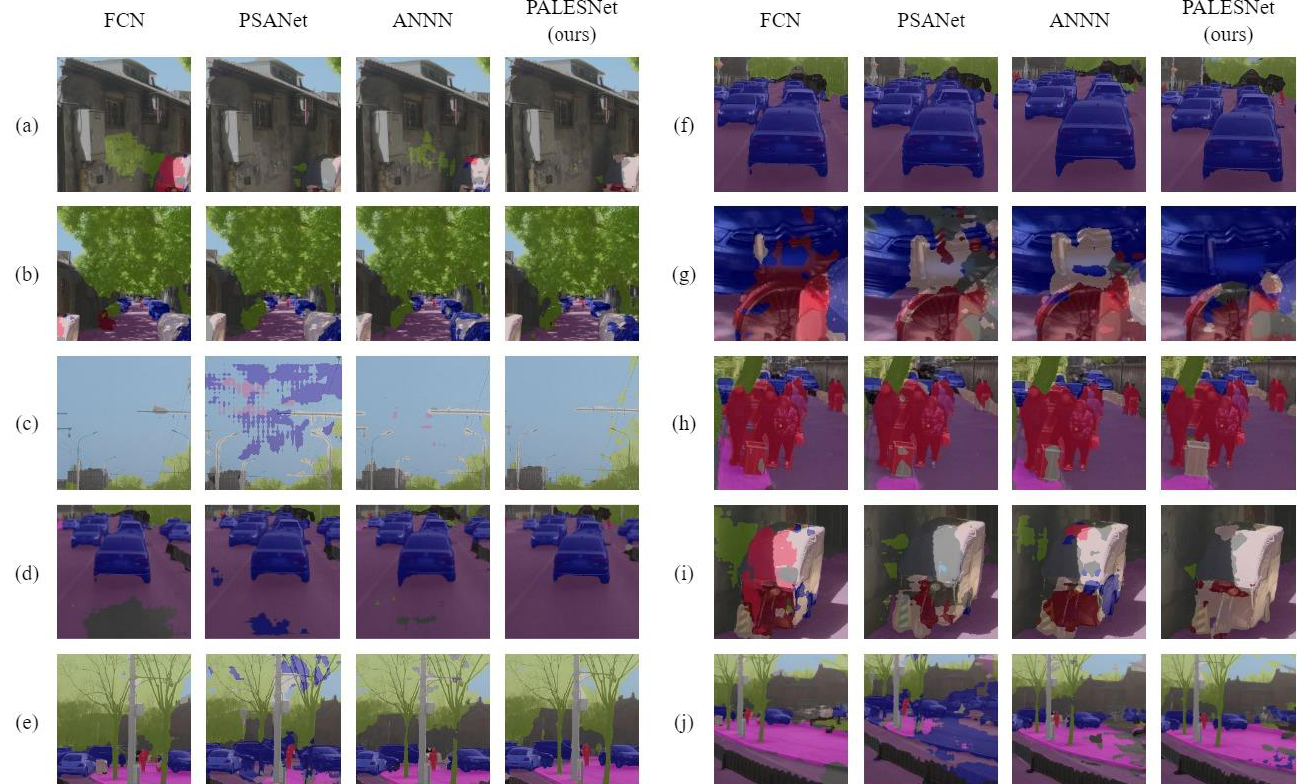
Figure 10. We show the category-by-category segmentation results for ( a ) building, ( b ) vegetation, ( c ) sky, ( d ) road, ( e ) sign, ( f ) motor vehicles, ( g ) non-motor vehicles, ( h ) person, ( i ) clutter, and ( j ) pavements, respectively.